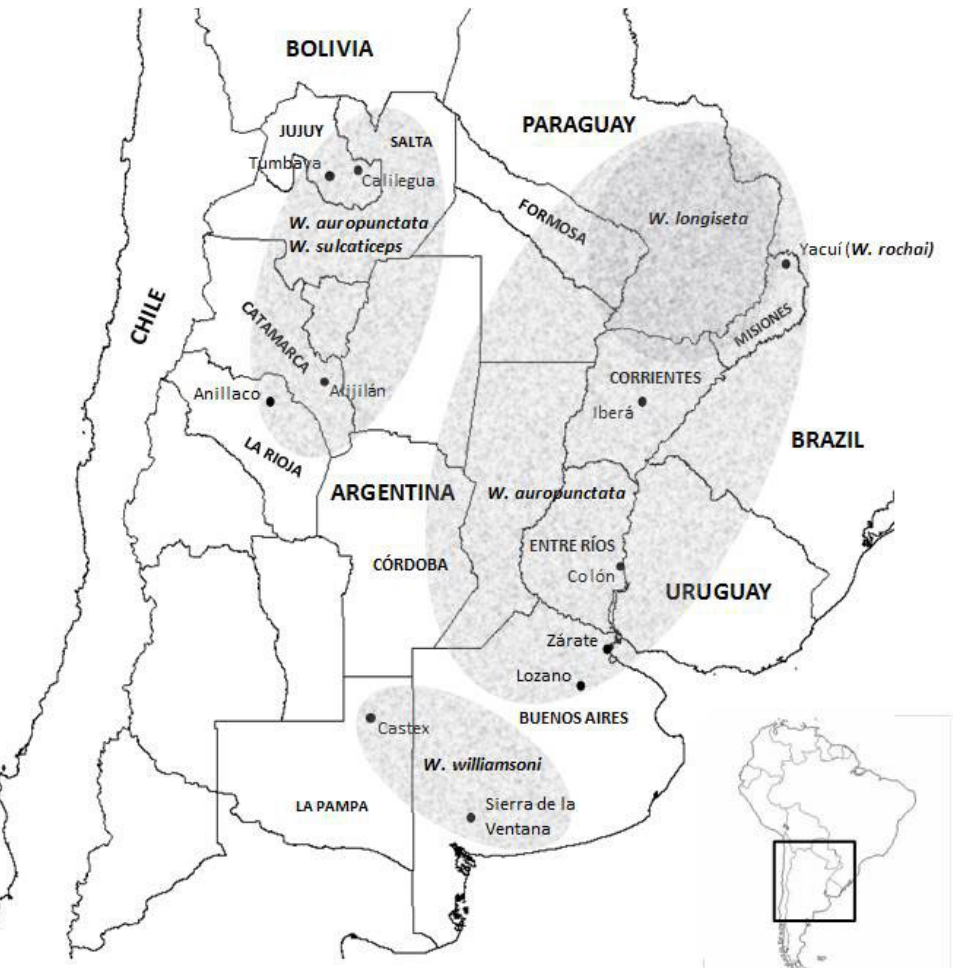
Fig 4 . Main distribution regions of the five species of Wasmannia found in Argentina, including several sites mentioned in the